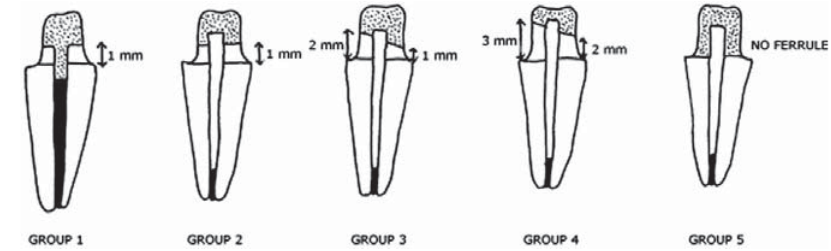
Figure 1- Schematic representation of the different tested